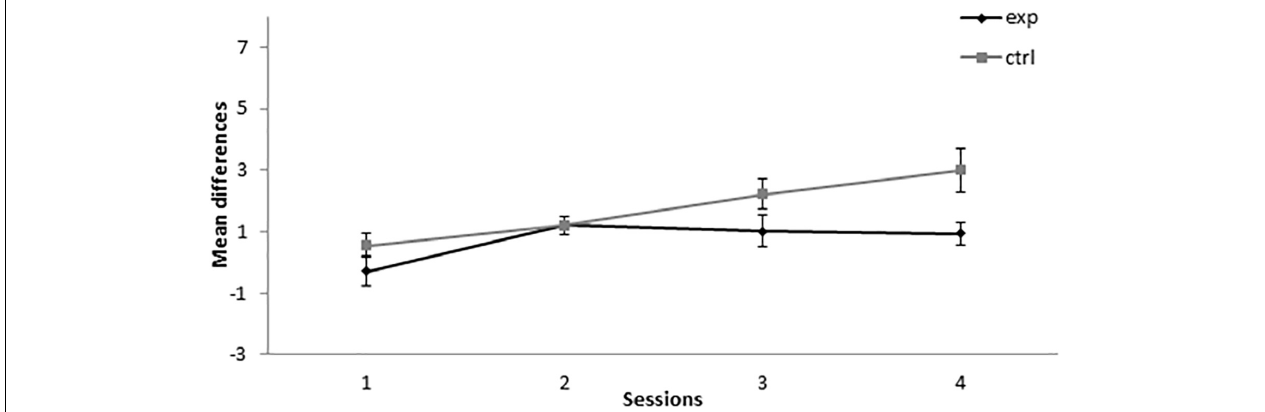
FIGURE 6 | Retardation test in Experiment 3. PreX-X differences ( ± SEM), averaged for the 10 X+ presentations per session in retardation, are displayed. The black line represents the group that was trained with five A+, 11 AX – , three F – , nine F+, and two X – presentations per session in conditioning. The gray line represents the group that was trained with eight A+, five A+, 11 BX – , three F – , nine F+, and two X – presentations per session. In the retardation test, both groups received 10 X+ presentations per session.